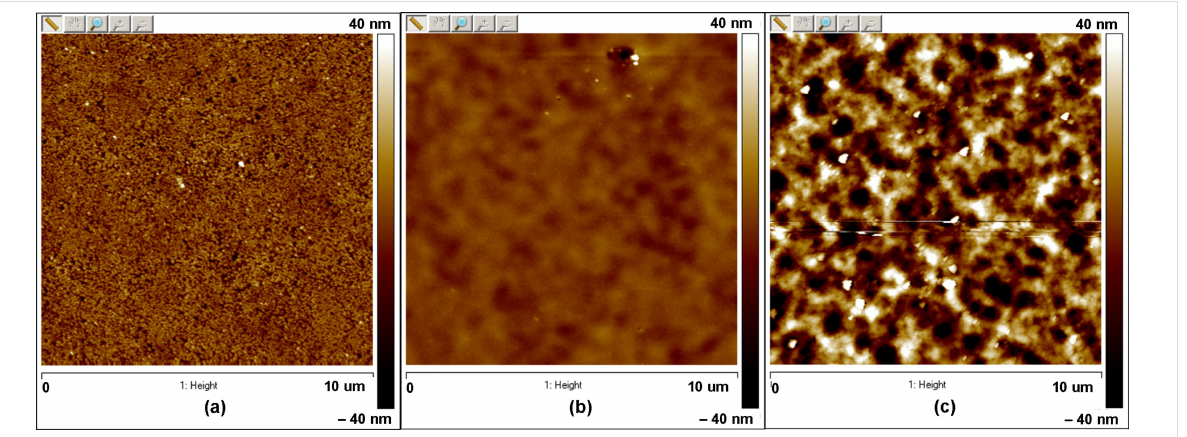
Figure 5: AFM images of the Si nanopowder surface before (a) and after irradiation by the cluster beam at an ion dose of 5.8 × 10 15 cluster/cm 2 and energy of 34.5 keV (b) and 17.3 keV (c).